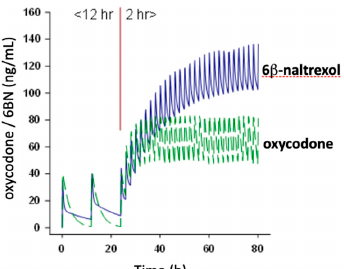
Figure 6. Simulated plasma levels of oxycodone (20 mg) co-administered s.c. with 6BN (15 mg). The pharmacokinetic model is based on published human blood level data for both compounds, assuming